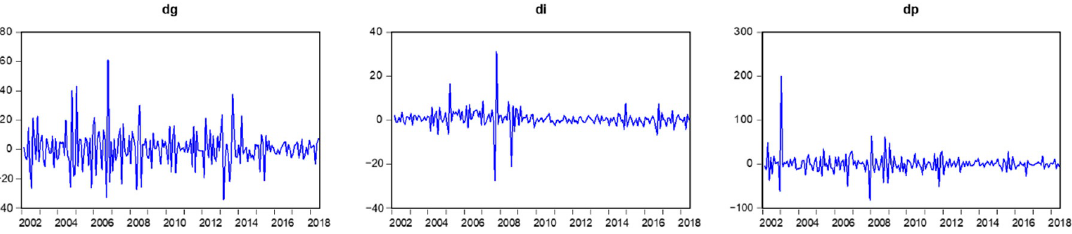
Figure 1. Plots of the variables (in logarithmic scale). notes: g, i, and p are gasoline demand and income, both in per capita terms, and real gasoline price, respectively.